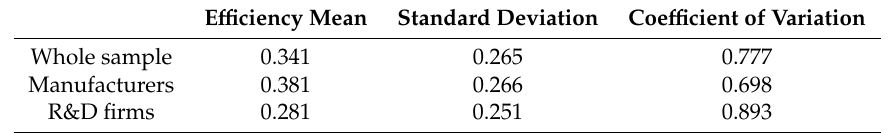
Table 1. E ffi ciency in the pharma and biotechnological European industry by activity,